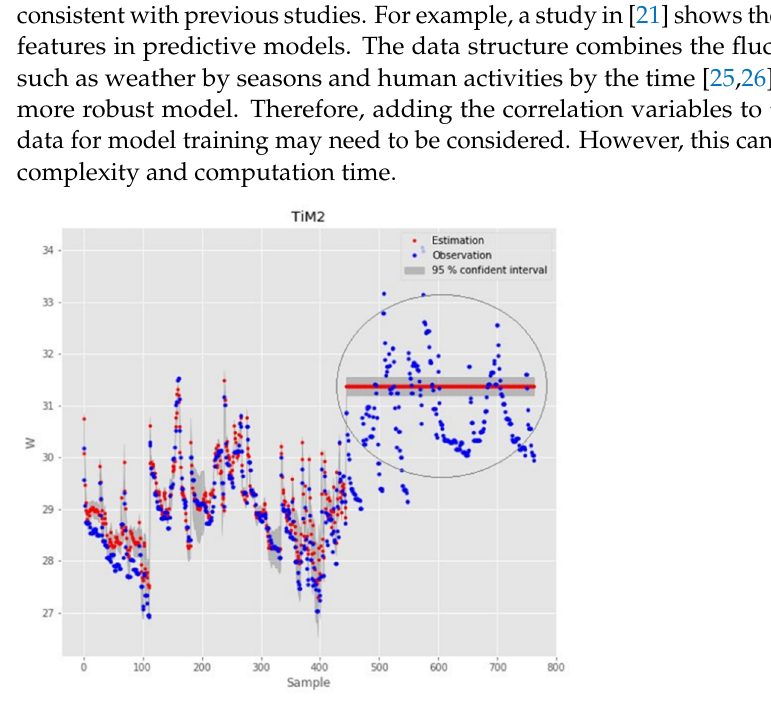
Figure 12. Estimation and observation of indoor temperature TiM2 in August. Splitting to the sub-datasets for GPR models will speed up the model computation while ensuring prediction results. Furthermore, the length of the dataset in this experiment is about 200 samples for the training model, and the computation speed is less than 5 s, which is quite suitable for the online